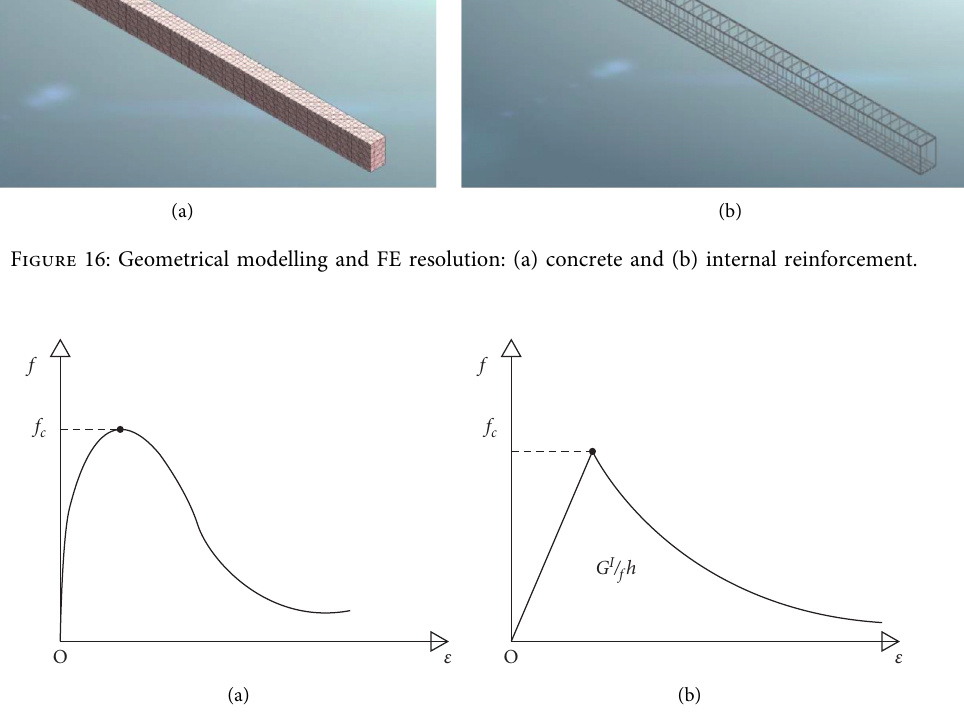
Figure 17: Material constitutive laws: (a) compression and (b) tension.